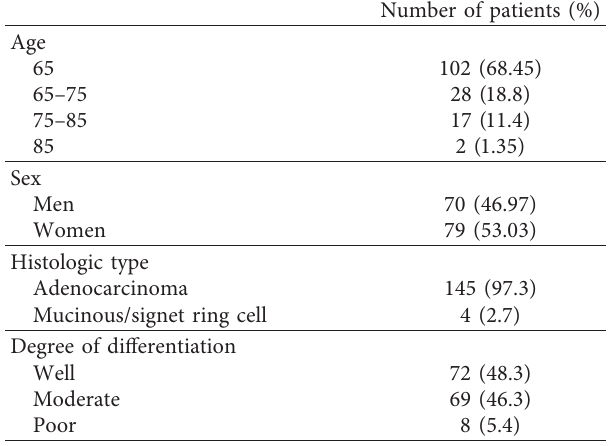
Table 1: Patient and therapeutic effect on lymph nodes characteristics.